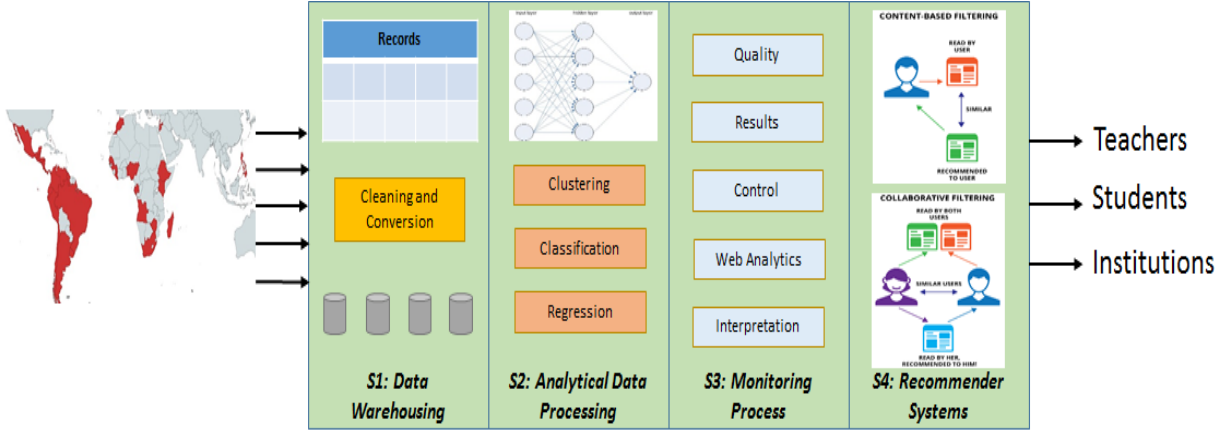
Figure 3. Intelligent virtual educational system design.